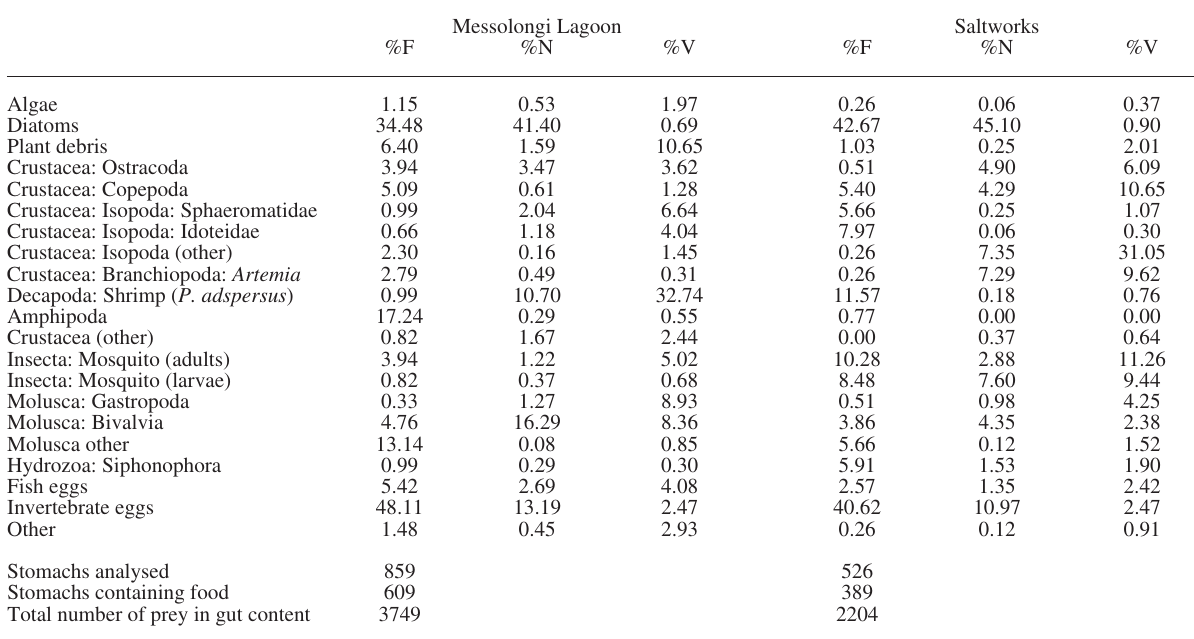
Table 1. – diet of Aphanius fasciatus in Messolongi Lagoon and saltworks: %number, %Volume and Frequency of occurrence of the main food